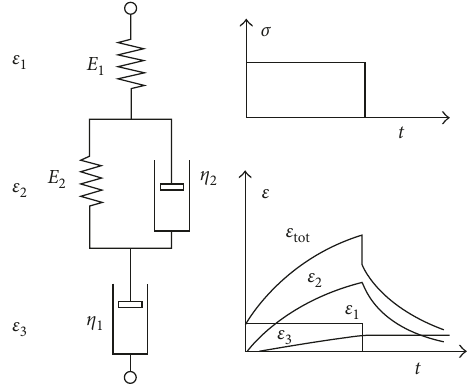
Figure 3: The Burgers model and its creep